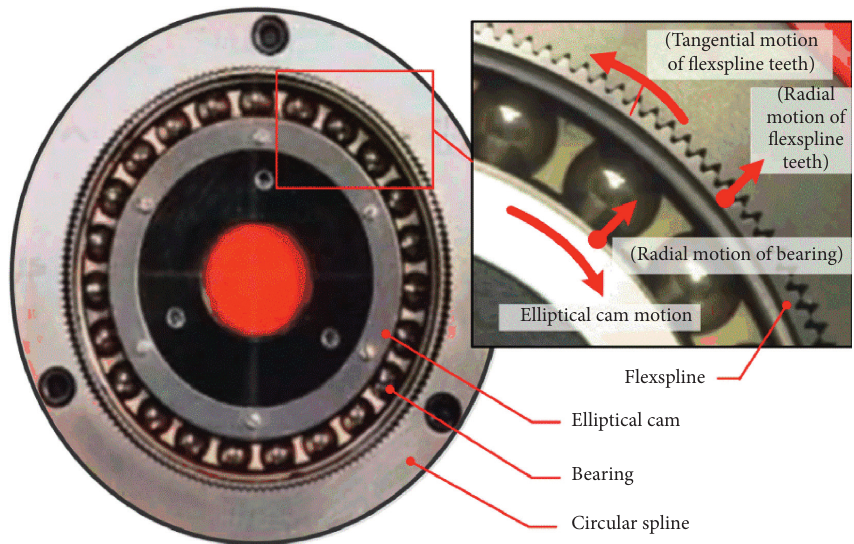
Figure 2: Structural relation and motion form of harmonic drive